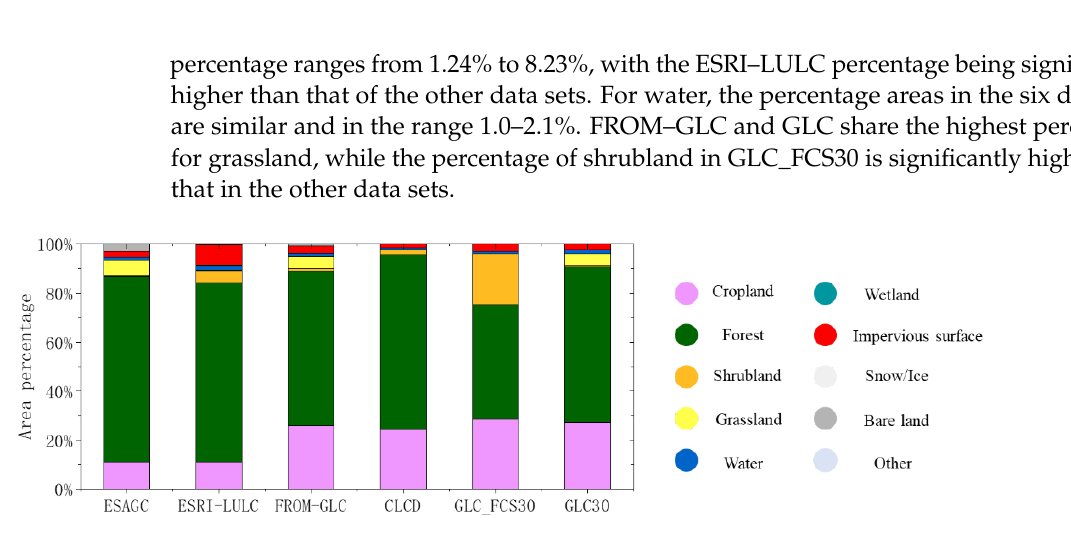
Figure 3. The composition of the six land cover products in Guangxi by cover type.